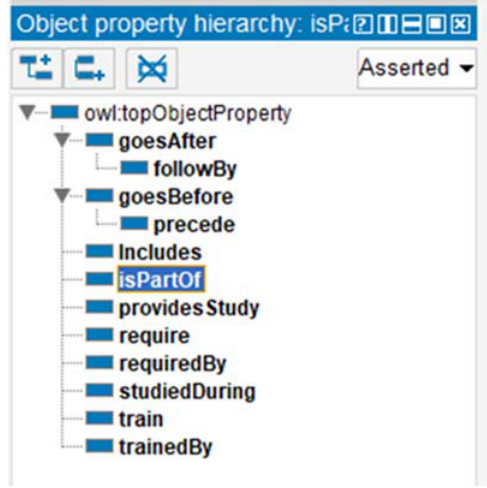
Figure 8. Hierarchy of object properties.